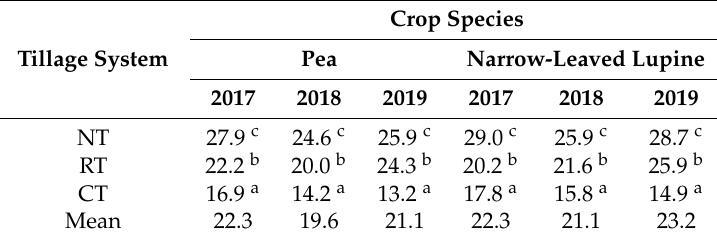
Table 3. Dry weight of weeds (g·m −2 ) in different tillage system in term before harvest in 2017–2019. Crop Species Tillage System Pea